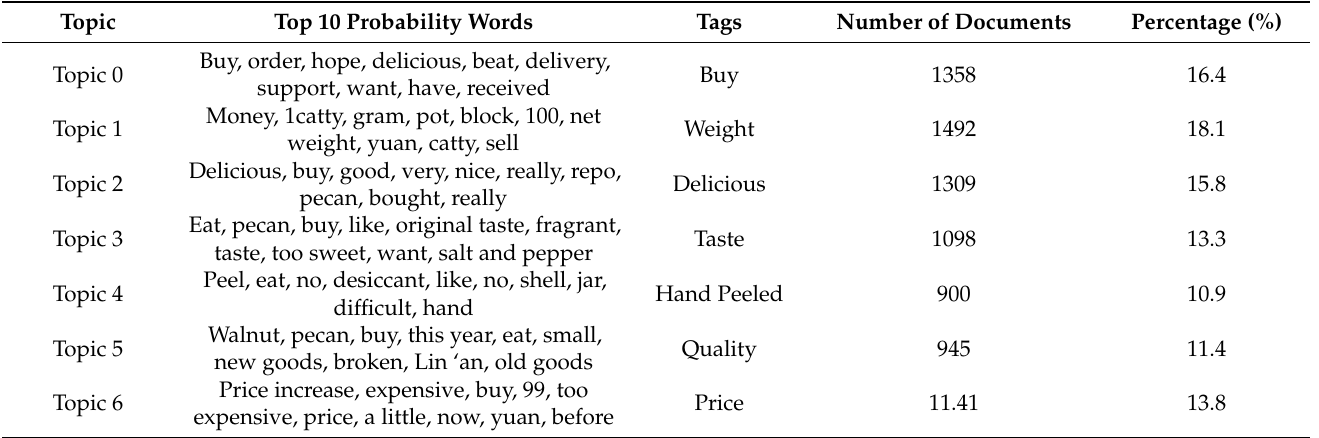
Table 3. Carya cathayensis review word-topic distribution and classification